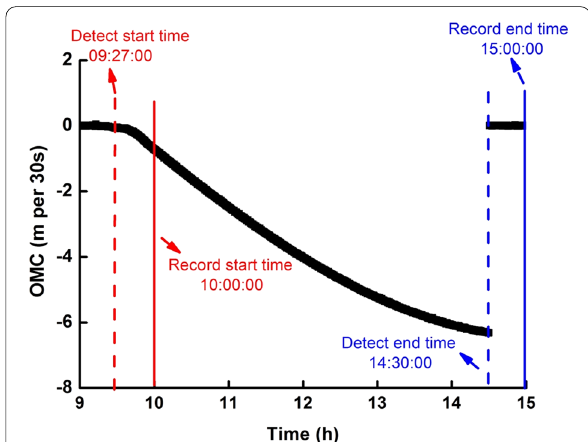
Fig. 7 The time series of the OMC values of the epoch-differenced observations at station CUT0 during the orbital maneuver period. Here, the red line represents the start time and blue line represents the end time, while the dotted line represents the recorded time from the broadcast ephemeris, and the solid line represents the detected time by this study